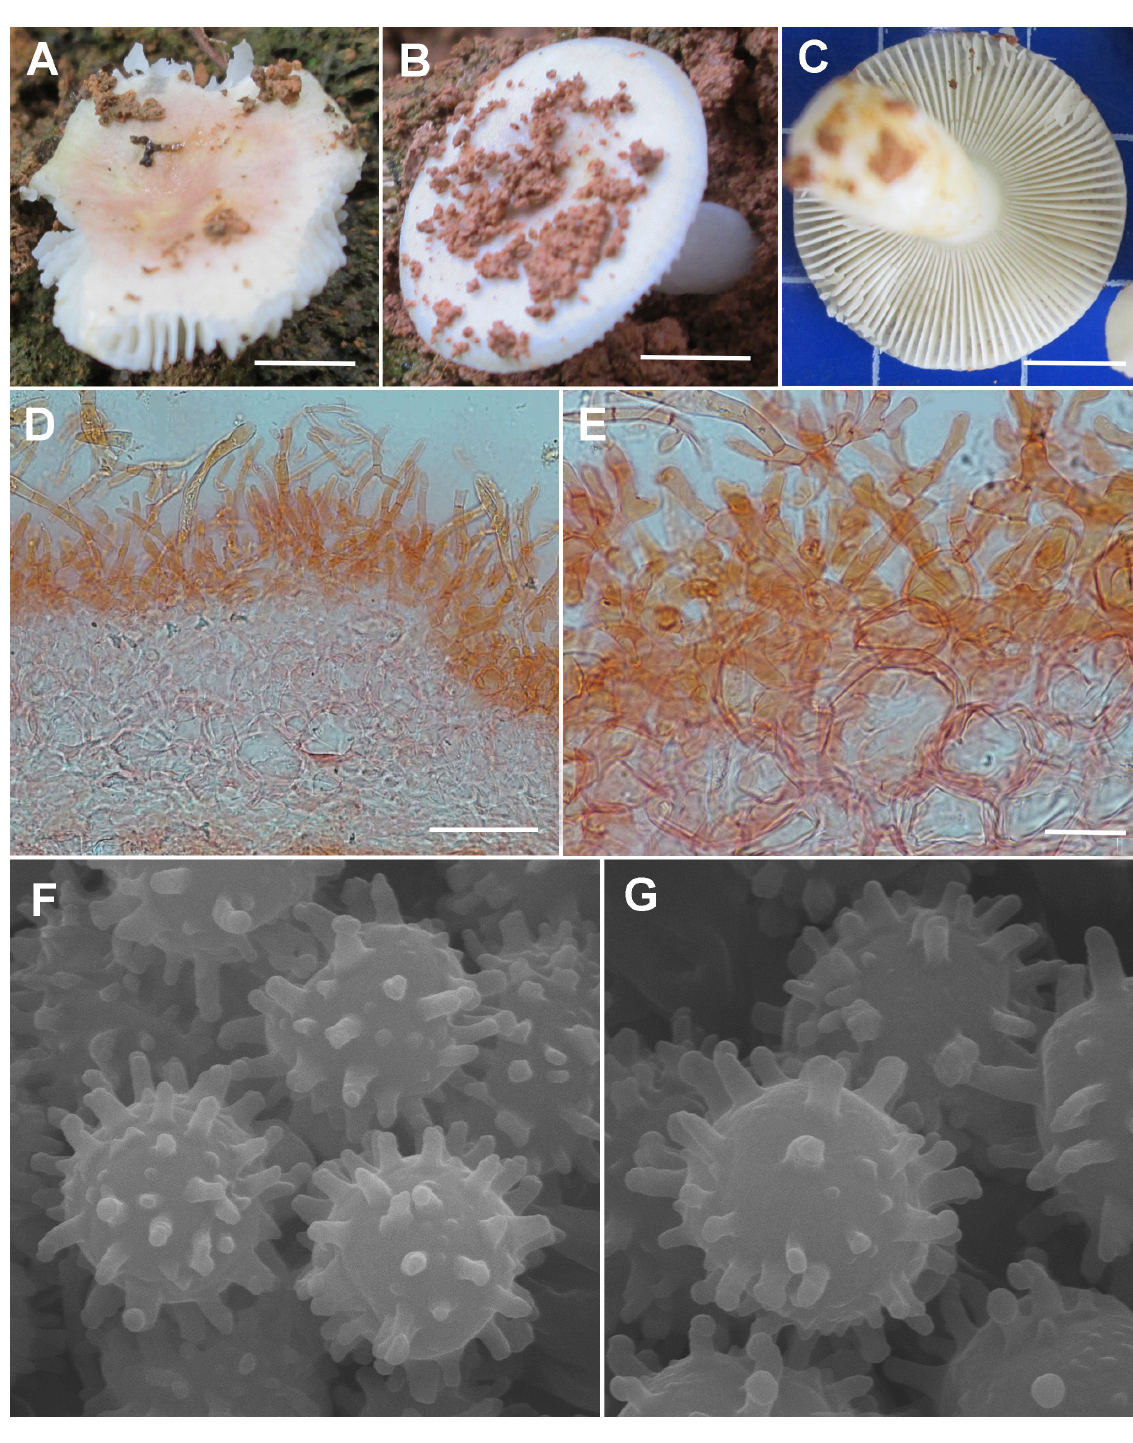
Fig. 3. Russula coronaspora Y.Song sp. nov. (GDGM79711, holotype). A–C . Fruiting bodies. D–E . Pileipellis. F–G . Basidiospores under scanning electron microscope. Scale bars: A–C = 1 cm; D = 25 μm; E = 10 μm; F–G = 2